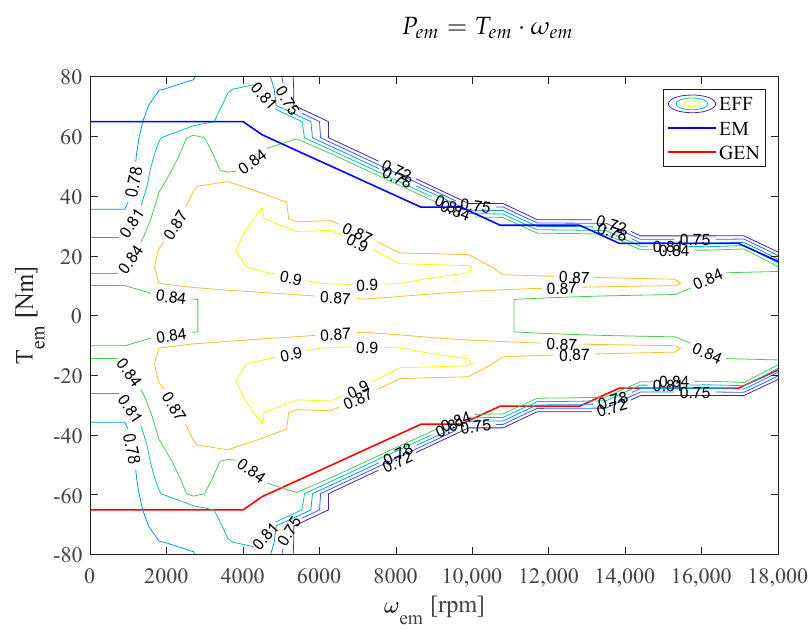
Figure 5. Static efficiency map of the electric motor and maximum torque characteristic lines.